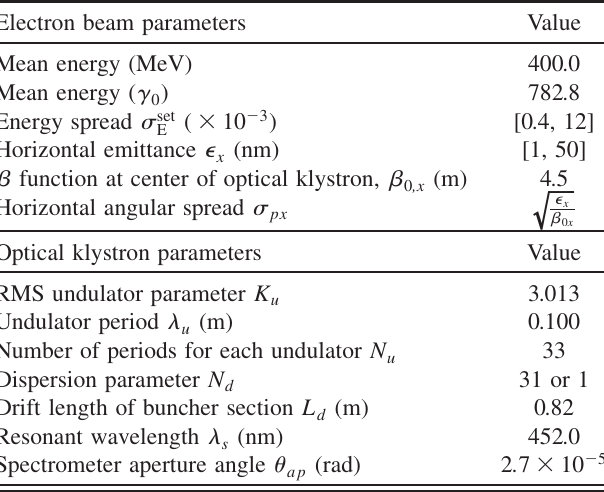
TABLE I. Electron beam and OK parameters for generating simulated spectra.